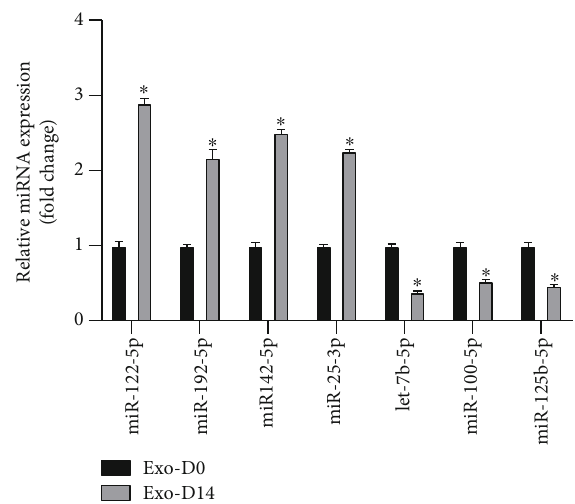
Figure 6: Validation of RNA sequencing data by qRT-PCR. miRNA expression was normalized to U6 expression. N = 3 /group, ∗ p < 0 : 05